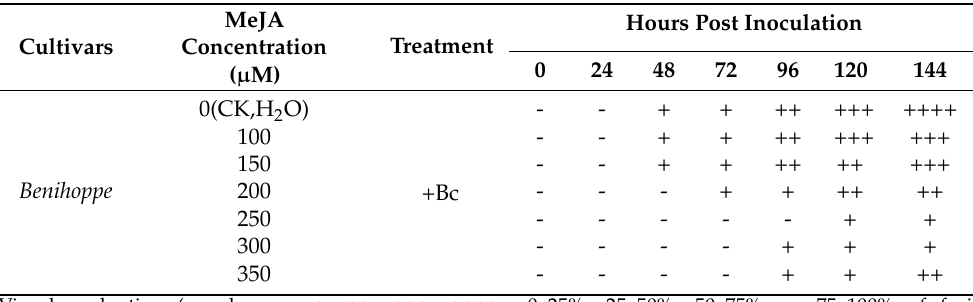
Table 1. Incidence (%) of Botrytis cinerea in Fragaria × ananassa Duch. “Benihoppe” fruit after 3 days of treatment with different concentrations of